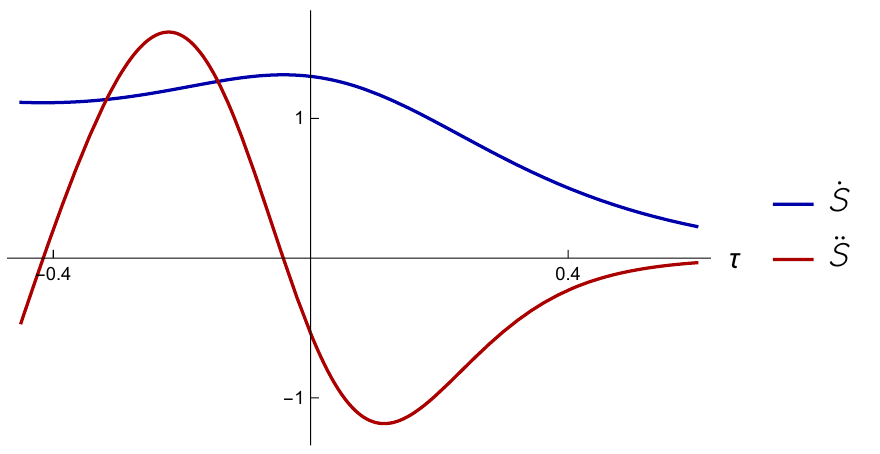
˙ ¨ S ( T ) , S ( T ) as a function of τ , for c B = 1 , r = 0 . 075